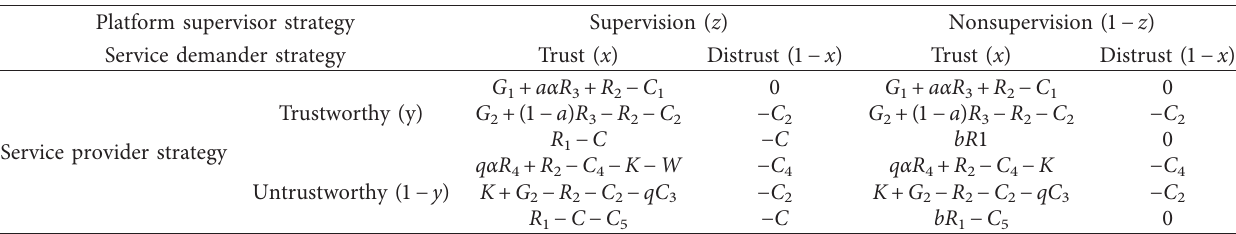
Table 2: Perceived benefits matrix of the evolutionary game between the service demander, service provider, and platform supervisor. Platform supervisor